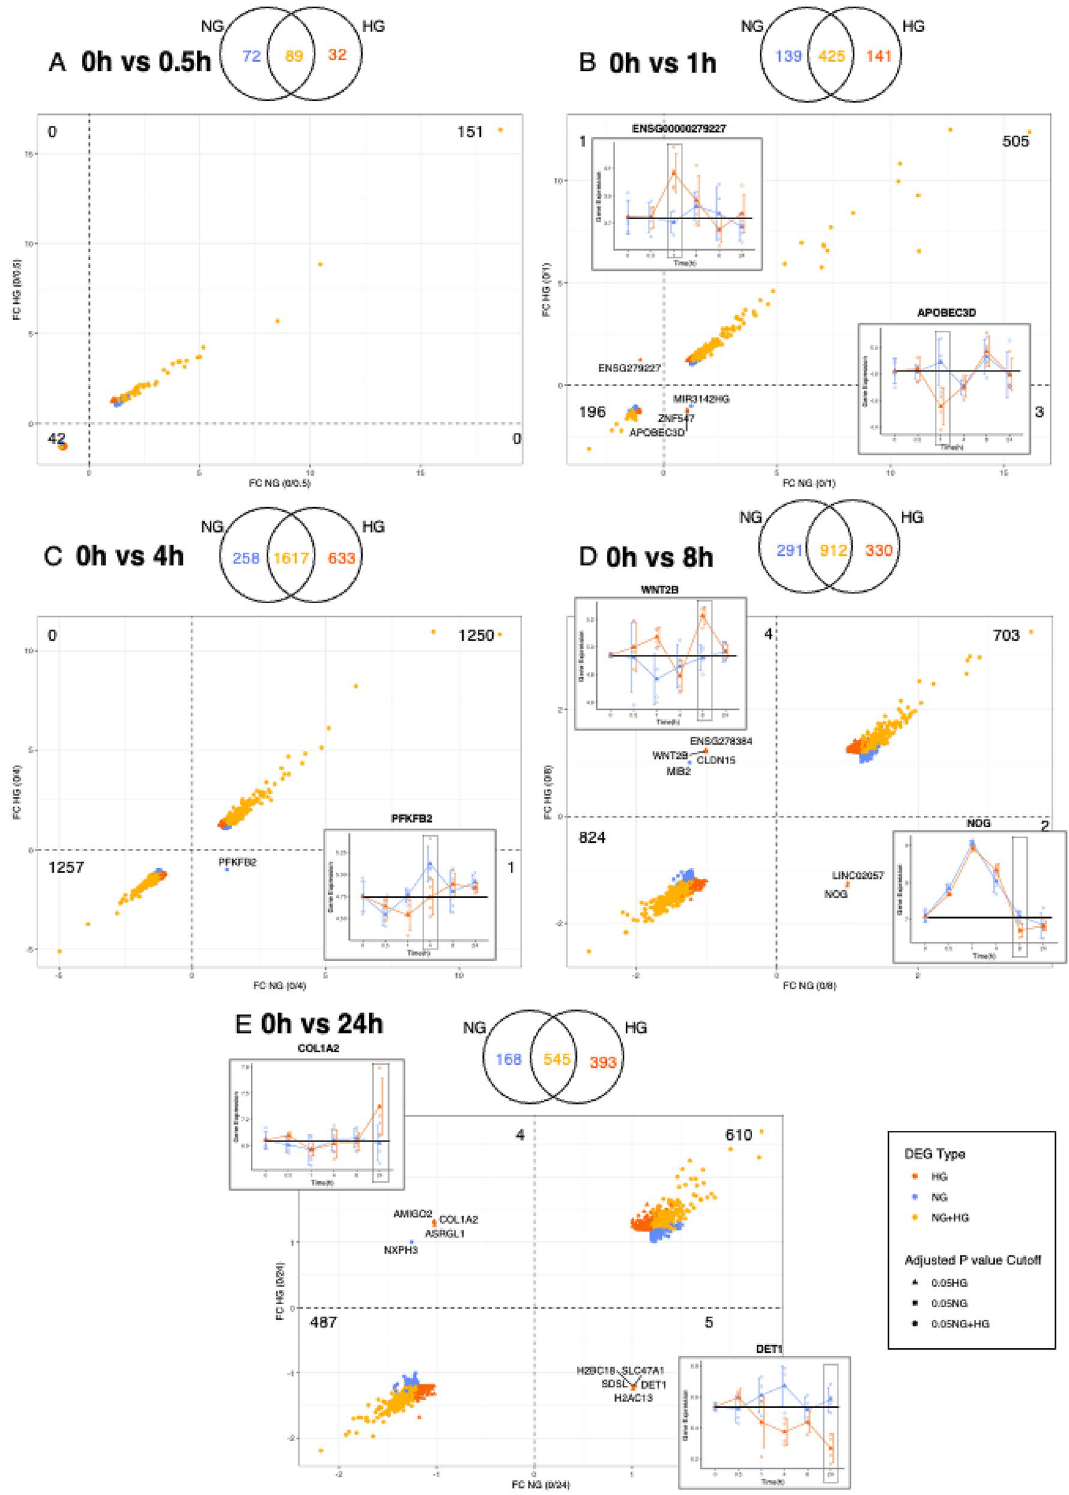
Figure 3. Differential glucose treatment results in transcriptional changes in HAECs. Venn analysis and scatterplots of fold change of DEGs (± 1.2 fold change, adjusted p-value < 0.05 for significance) with pairwise comparisons of each time point A) 0 h vs 0.5 h NG/HG, B) 0 h vs 1 h NG/HG, C) 0 h vs 4 h NG/HG, D) 0 h vs 8 h NG/HG, and E) 0 h vs 24 h NG/HG. Colour coding shows DEGs specific to HG (orange), NG (blue) or both NG and HG (yellow) conditions. Graph inserts plot fold change of individual genes that show opposite transcriptional responses in NG and HG conditions. Each replicate for each time point is plotted together with the mean average fold change, error bars show standard deviation. Red boxes highlight the baseline expression and where the difference in gene expression occurs between NG and HG